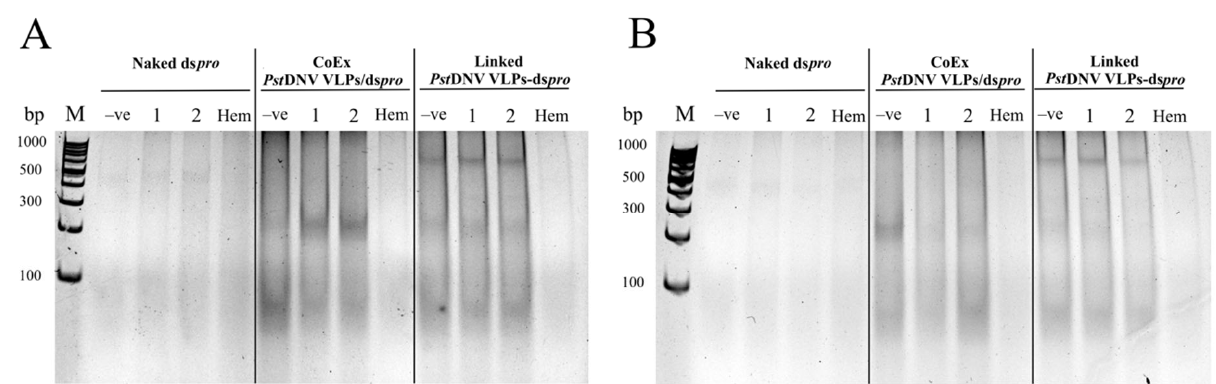
Figure 5. dsRNA protective efficiency of Linked Pst DNV VLPs-ds pro from hematopoietic enzyme degradation in shrimp. Total RNA isolated from Linked Pst DNV VLPs-ds pro was analyzed on a 12% TAE buffered-polyacrylamide gel following an incubation with hemolymph at 28 ◦ C for ( A ) 3 and ( B ) 6 h. Lane M, GeneRuler 100 bp DNA Ladder (Thermo Fisher Scientific, Waltham, MA, USA); Lane − ve, unincubated with hemolymph; Lane 1–2, incubated with hemolymph (duplicate experiments); Lane Hem, total RNA extracted from shrimp hemolymph .